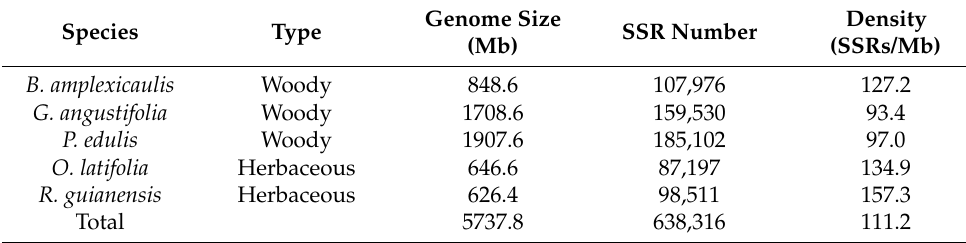
Table 1. A comparative survey of SSR identification across five examined bamboo